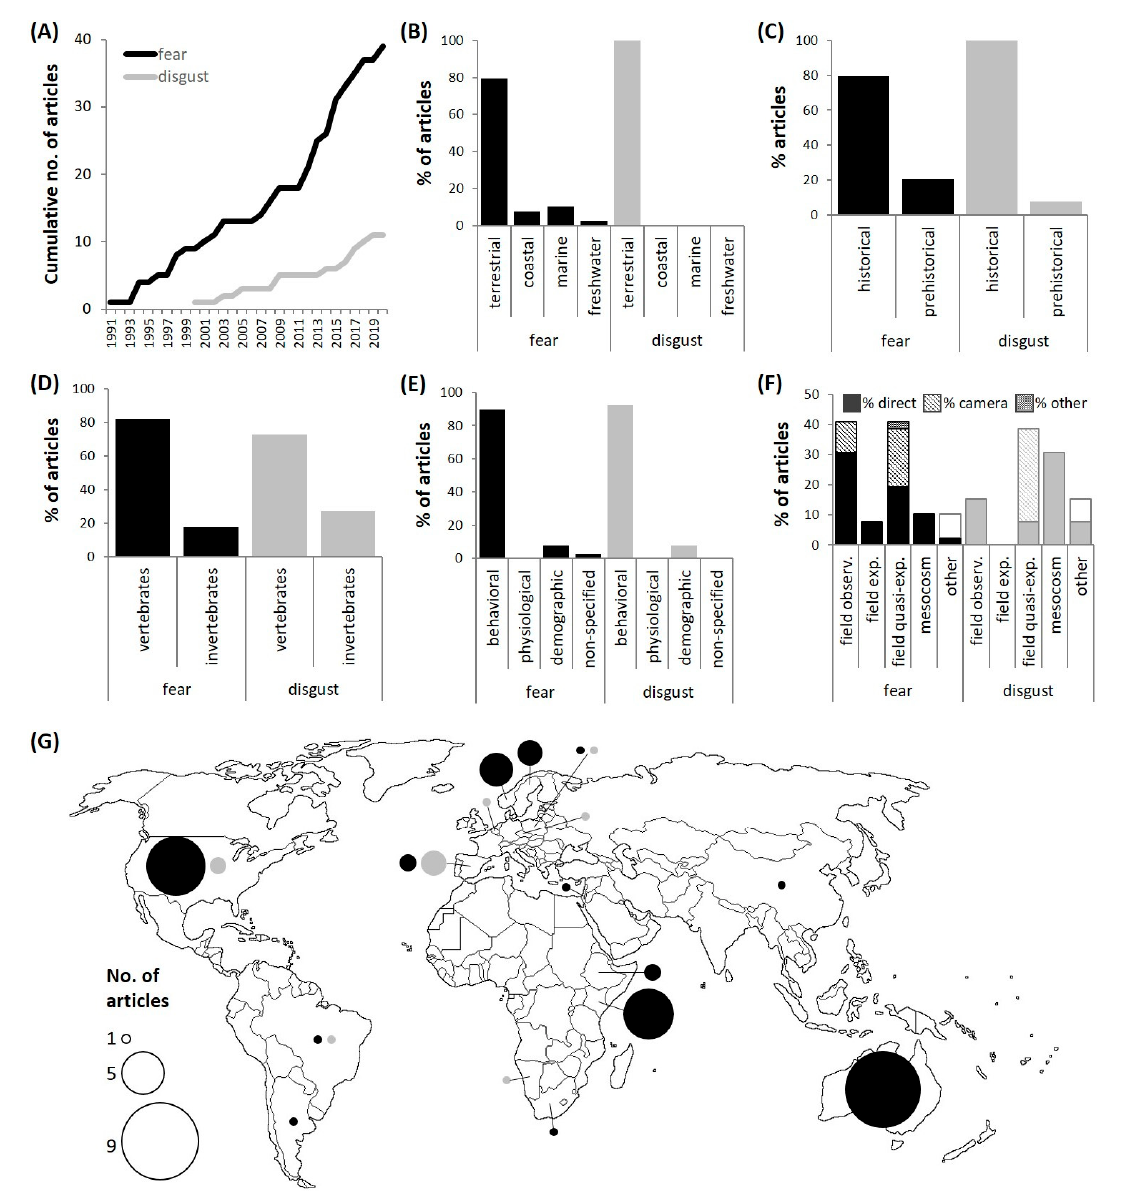
Figure 1. Distribution of reviewed articles according to publication year ( A ), ecosystem ( B ), period ( C ), type of animals at (potential) risk ( D ), effects of the risks on such animals ( E ), study design (different bars) and observation method (within bars) ( F ), and geographic location ( G ). See main text for details.